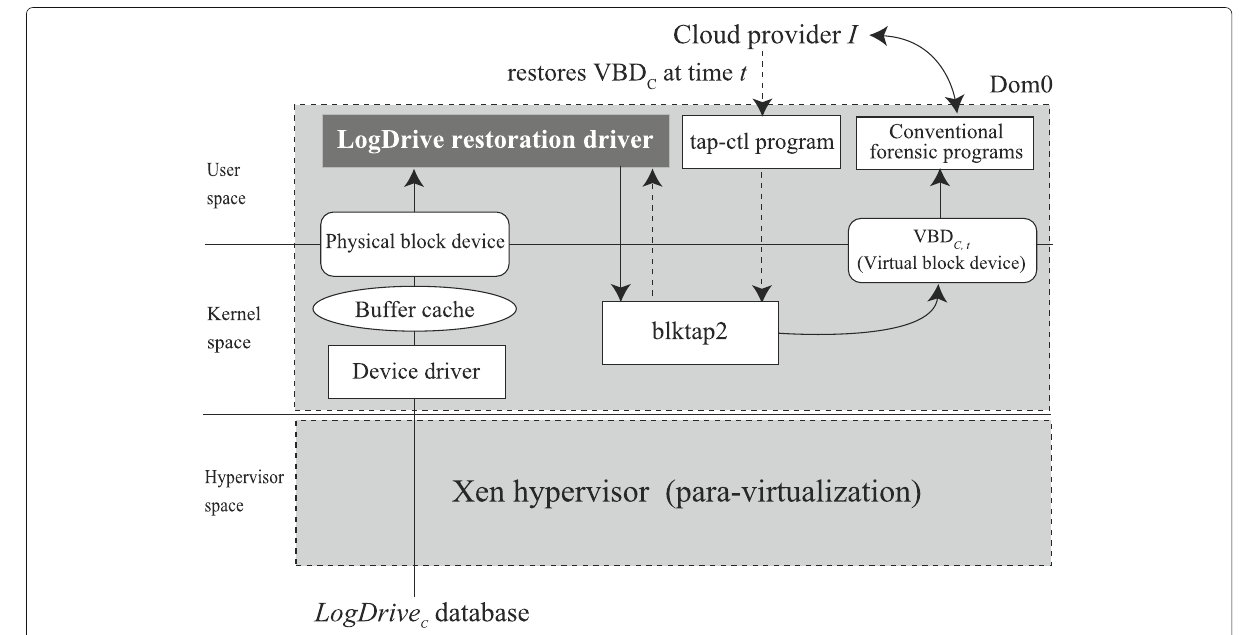
Fig. 8 Implementation of the restoration function of the LogDrive database